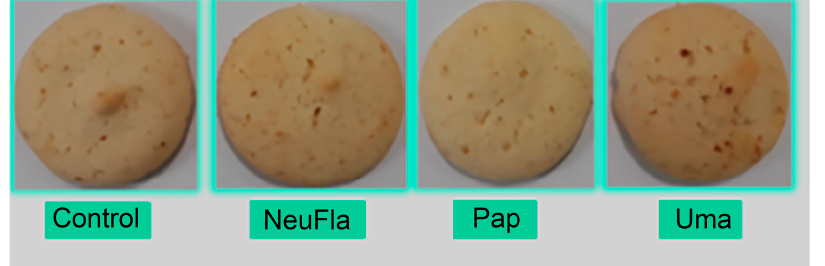
Figure 4. Photographic views of traditional cookies with wheat flour (control) and the cookie with added Pap, Umam, and NeuFlav hydrolysates.